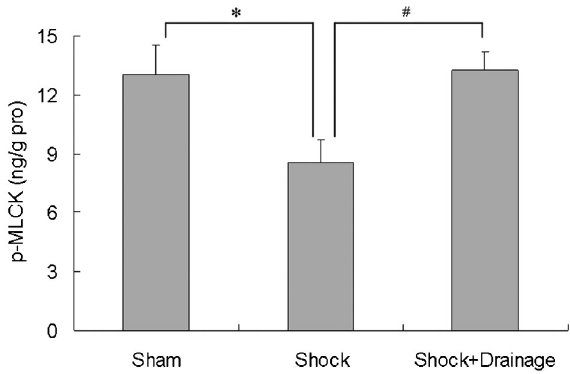
Figure 2. Myosin light chain kinase increases vascular reactivity on post-shock mesenteric lymph drainage in hemorrhagic-shock rats. Data are reported as means±SD (n=6). SP: substance P, an agonist of MLCK; ML-7: an inhibitor of MLCK. *P , 0.05 vs sham group; # P , 0.05 vs shock group, and + P , 0.05 vs shock++drainage group (one-way